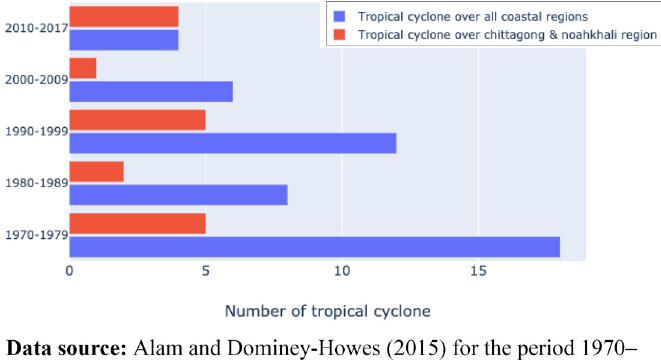
Figure 3. Decadal frequency of cyclonic storm over Chittagong and Noakhali coast and all the Bangladesh coastal regions during 1970 –